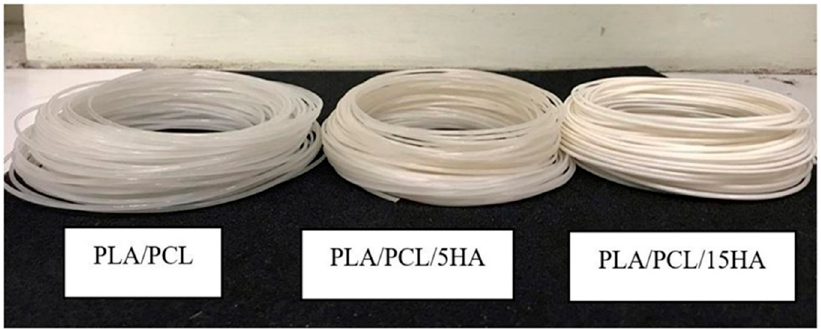
Figure 6. Appearance of the extruded composite filaments. Figure 6 . Appearance of the extruded composite filaments.